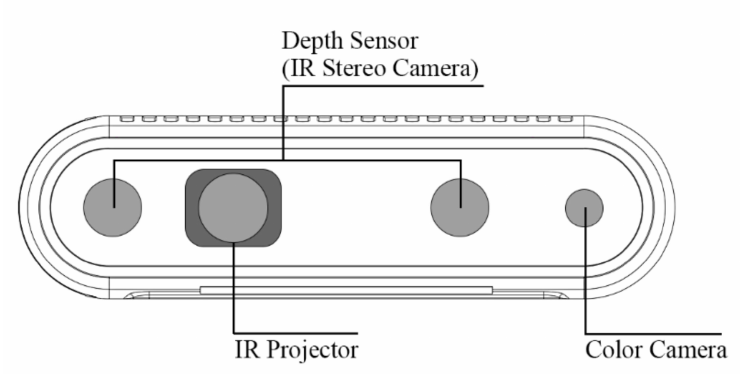
Figure 2. Sensor configuration of the Intel Realsense D435i depth